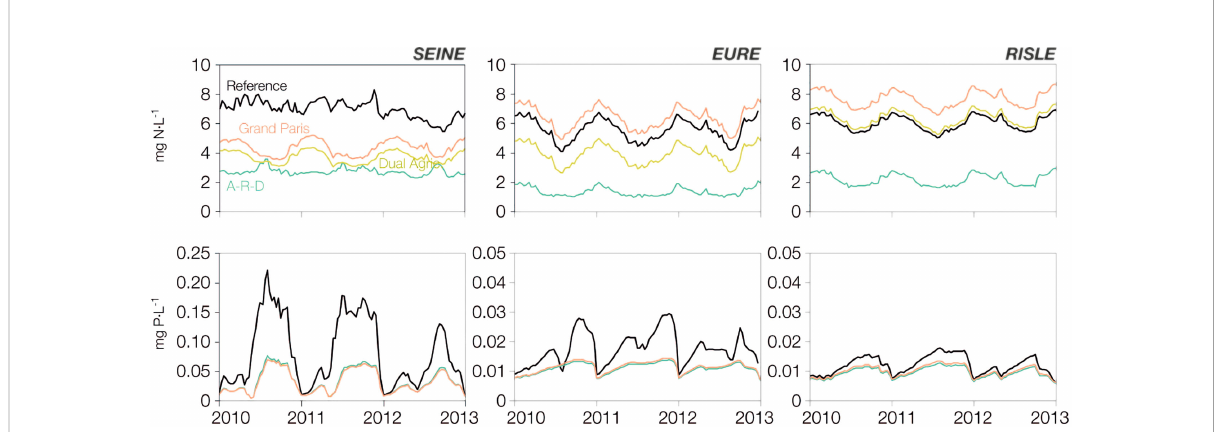
FIGURE 4 Interannual and seasonal dynamics of nitrate (top) and phosphate (bottom) concentrations for the reference conditions and for the different scenarios at the outlet of the Seine (Poses), the Eure and the Risle rivers. The scenarios were run over a 10-year period, but in order to emphasise the seasonal cycles and the resulting concentrations at the end of the period, only the last three years are shown here. Note that 10 mg N/L correspond to 714 µmol/L, and 0.05 mg P/L correspond to 1.6